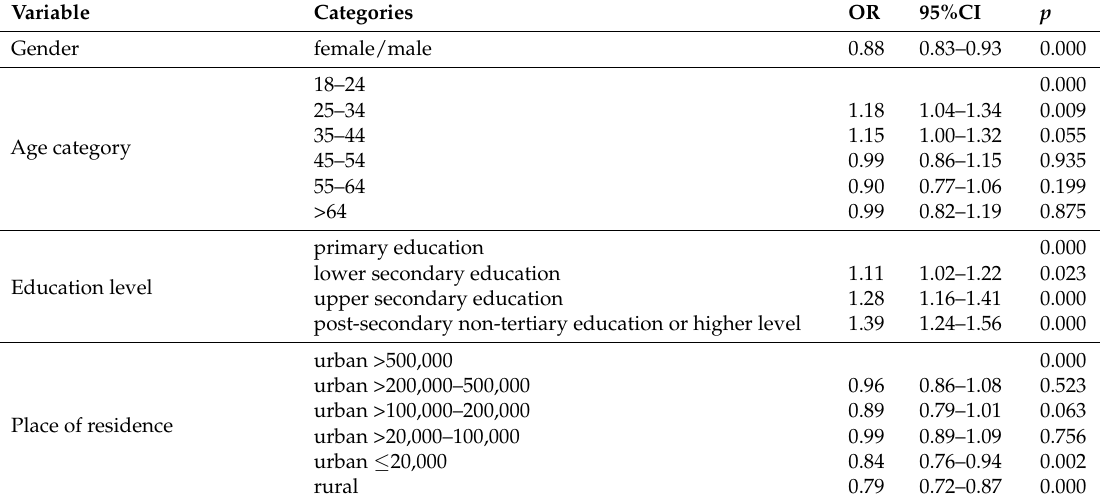
Table 2. Multivariate logistic regression results for opinion about the effectiveness of health-related social